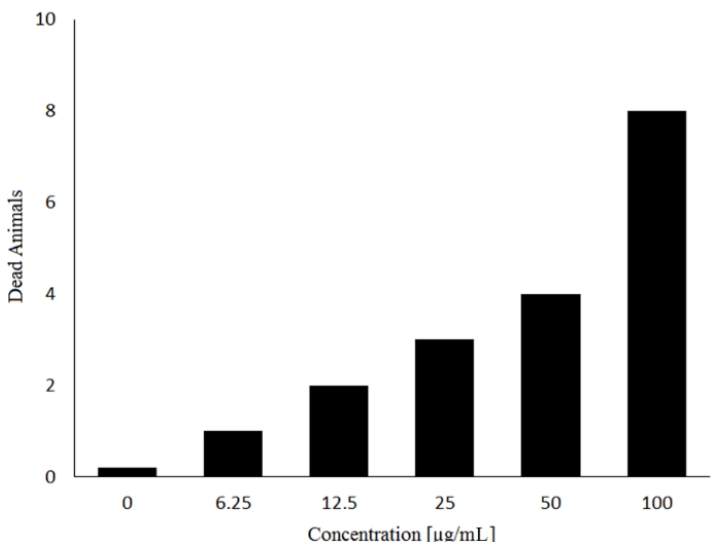
Figure 5. Toxic effect of DlyL at different concentrations on Artemia sp.